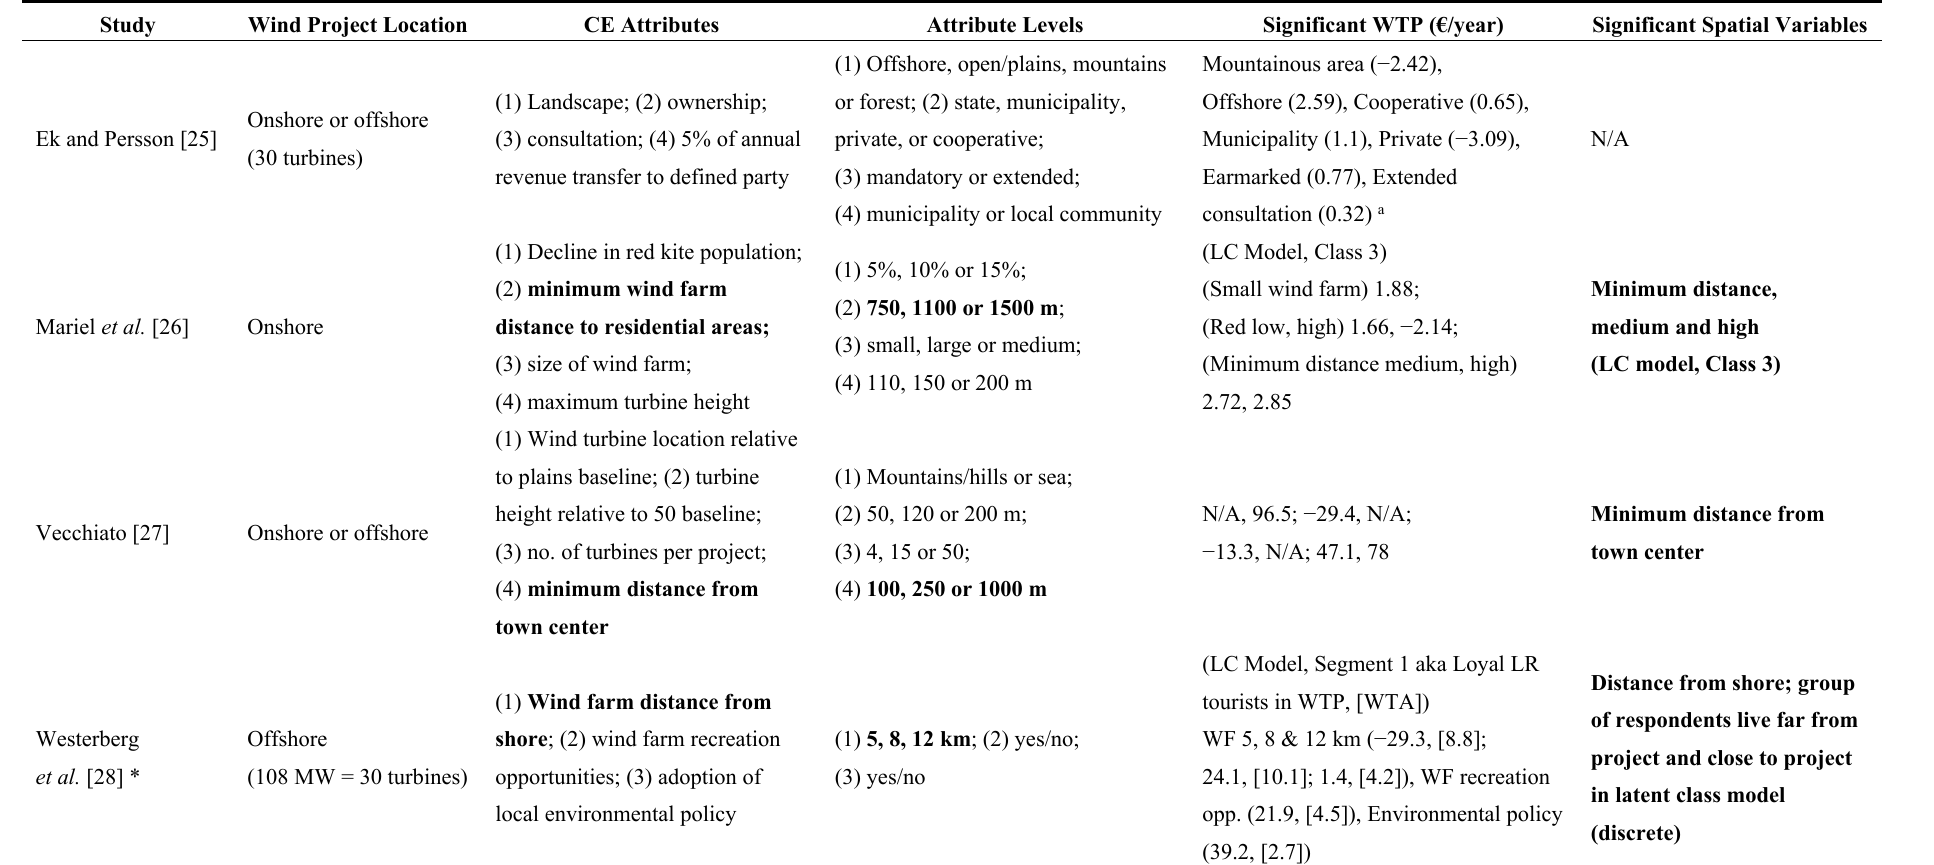
Table 1. Peer-reviewed choice experiment studies estimating stated preferences (SP) for onshore and offshore wind power. Adapted from Ladenburg and Dubgaard [23] and Strazzera et al.